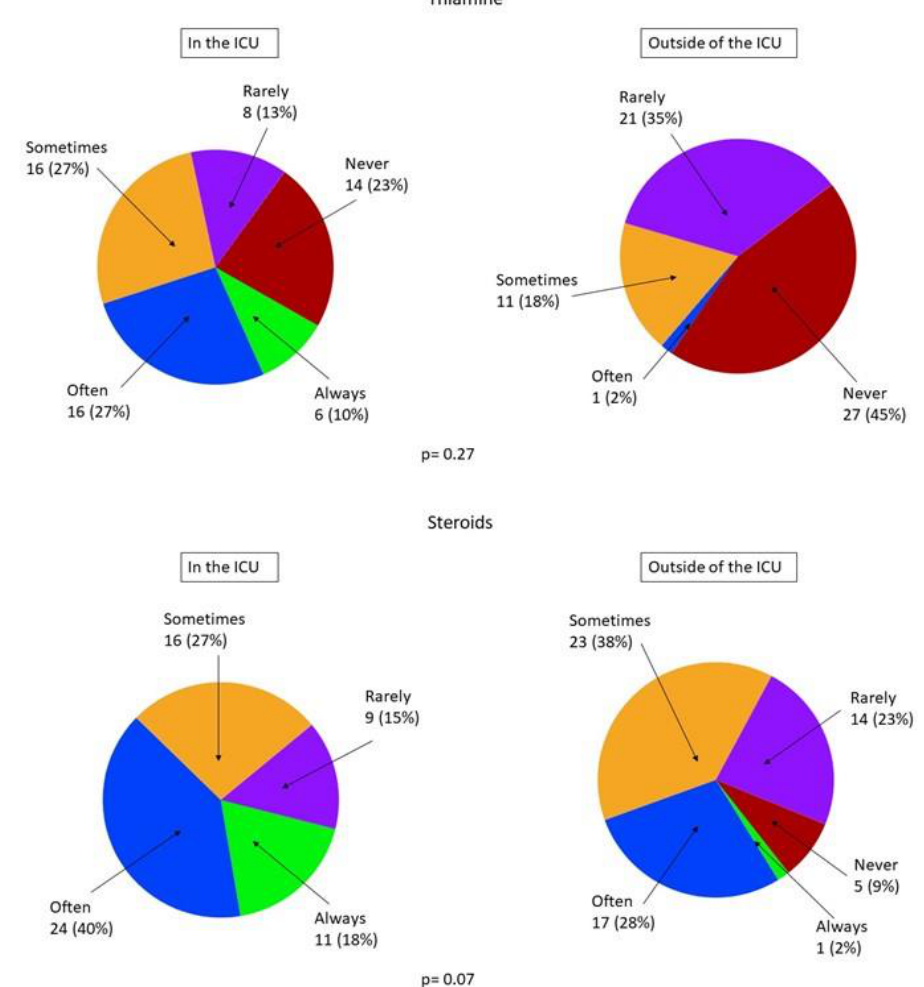
Figure 4. Application of the Vitamin C, Thiamine and Steroids in Sepsis (VICTAS) protocol in the ICU and outside the ICU environment.